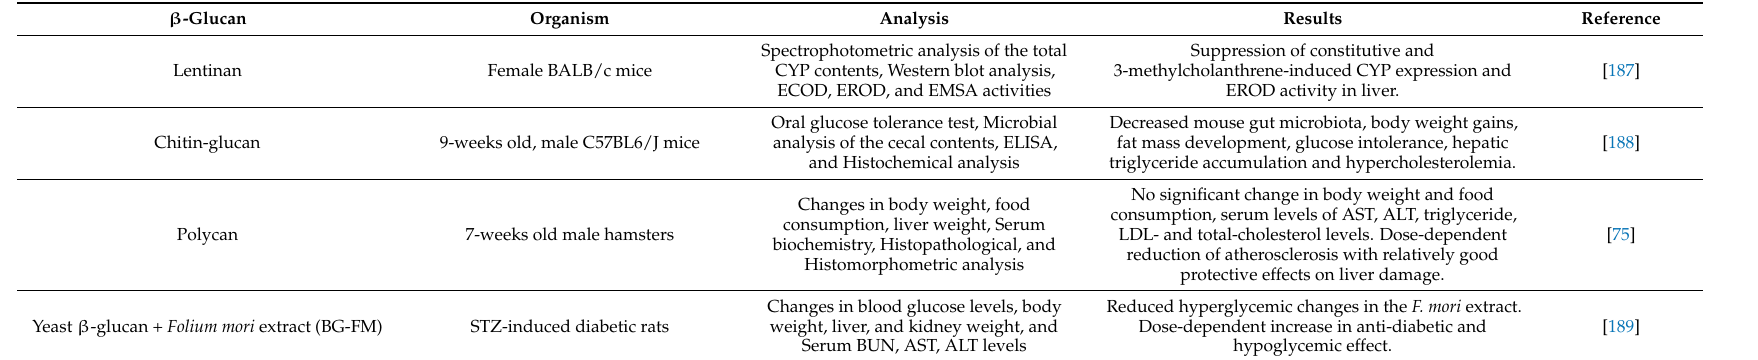
Table 11. Anti-diabetic/anti-obesity effects of β -glucans—animal